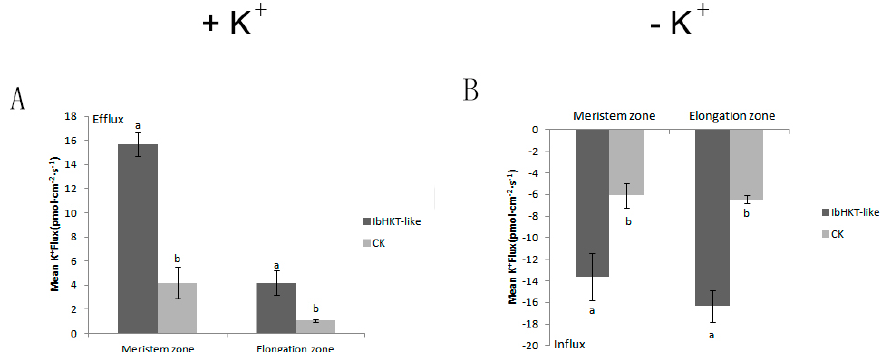
Figure 4. Steady-state K + flow in CK and transgenic roots under different treatments. ( A ) Mean net K + efflux rates in meristem and elongation zone of transgenic and CK roots. ( B ) Mean net K + influx rates in meristem and elongation zone of transgenic and CK roots. The ordinate is the net K + fluxes. Values indicated the mean and standard deviation of biological repetitions ( n = 3): different letters indicated extremely significant p < 0.05. CK: CK plants; IbHKT-like : IbHKT-like overexpressing roots.